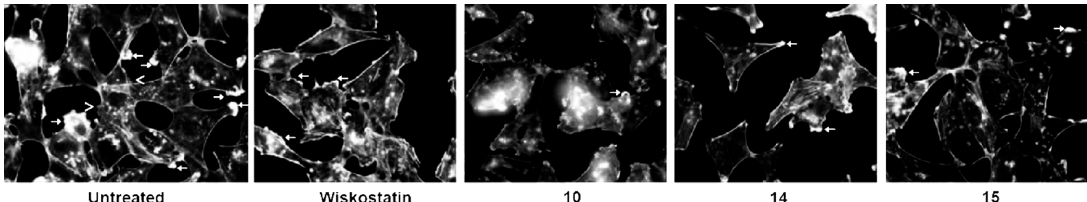
Figure 4. Effect of Wiskostatin and compounds 10 , 14 , and 15 on actin cytoskeleton of metastatic cancer cell MDA-MB-231. MDA-MB-231 metastatic breast cancer cells were treated with vehicle or Wiskostatin (2 µM) and compounds 10 , 14 , or 15 at 10 µM for 24 h to determine changes in actin cytoskeletal structures. Cells were fixed, permeabilized, and stained with rhodamine phalloidin to visualize F-actin. Arrows, lamellipodia; arrowheads, filopodia.